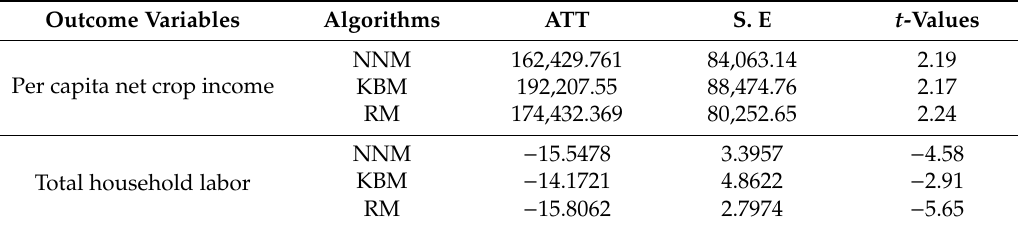
Table 5. Average treatment e ff ect of MT on per capita net crop income and labor